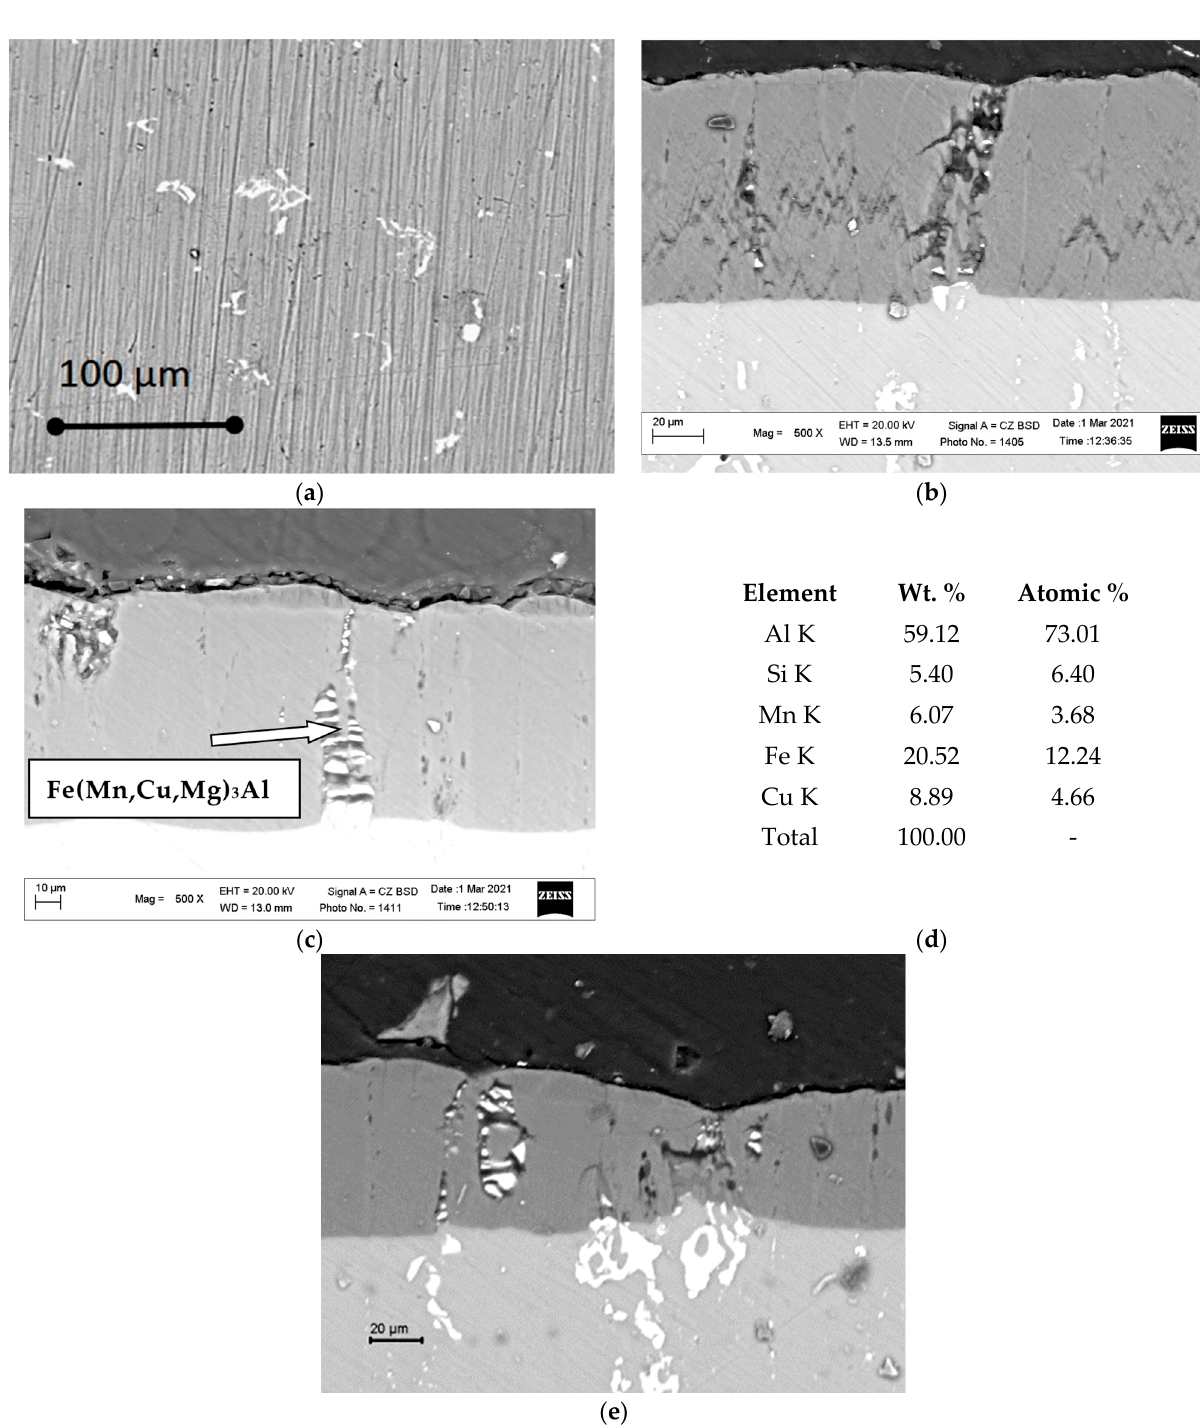
Figure 6. ( a ) General view of intermetallic particles on the outer surface of the anodized layer synthesized for 1 h at a temperature of − 4–0 °C; ( b ) the formation of micron-sized pores at the site of intermetallic inclusions that appear in the cross section of the anodized layer; ( c ) intermetallic particles and their typical composition; ( d ) the results of X-ray spectral analysis of Fe(Mn, Cu, Mg)3Al intermetallic compounds, indicated by an arrow in the photomicrograph in Figure 6c; ( e ) bending of the anodizing front as it approaches large inclusions in the structure of the base 1011 aluminum alloy.